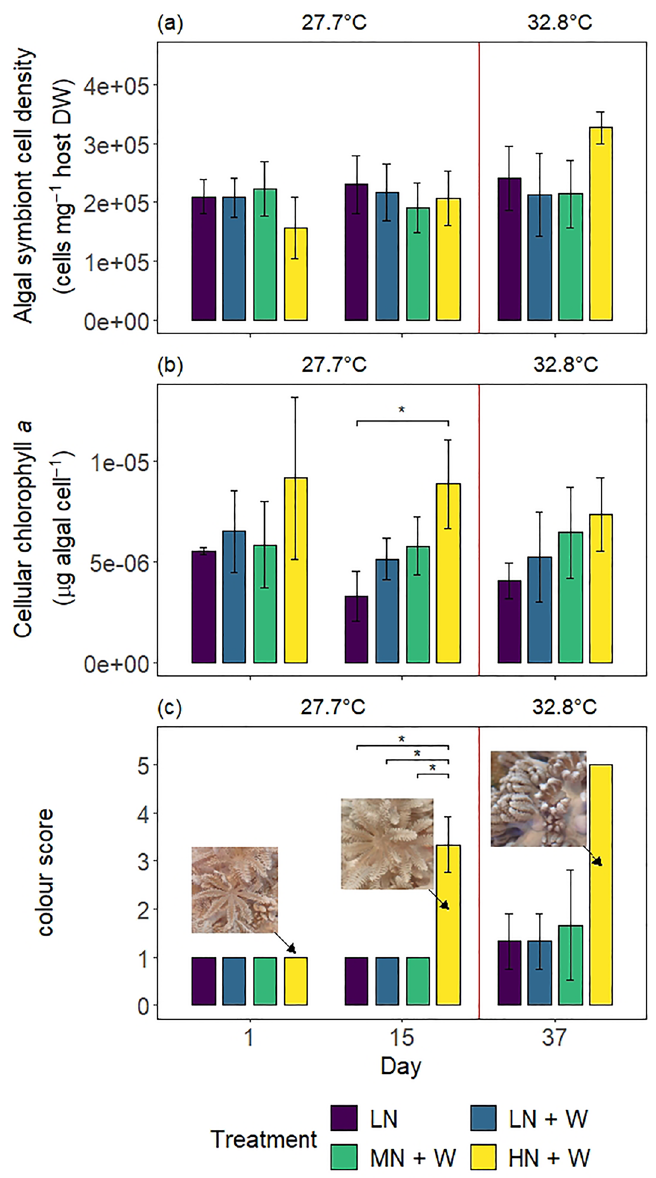
Figure 4. ( a ) Algal symbiont cell density, ( b ) chlorophyll a content standardized to cell density, and ( c ) colour scores (definitions in Supplementary Table S2, see also Supplementary Fig. S3) of Xenia umbellata colonies from control tanks with low nitrate (LN, ~ 0.6 μM) and three treatments: LN + W = low nitrate (~ 0.6 μM) + warming from day 17; MN + W = medium nitrate eutrophication (~ 6 μM) + warming from day 17; HN + W = high nitrate eutrophication (~ 37 μM) + warming from day 17. Error bars represent standard deviations of three replicates, with one exception of two replicates for the LN + W treatment on day one for both, ( a ) and ( b ). Temperatures represent mean temperatures of the respective days, excluding controls (LN). Asterisks represent significant differences between treatments within days (pwc, Bonferroni adjustment, t -test ( b ) or Dunn’s test ( c ), * = p < 0.05). Post-hoc test in ( c ) was conducted excluding day 1. Pictures in ( c ) show representative polyps of one identical X. umbellata colony in the high nitrate treatment at the respective time points (as indicated by arrows). Images in ( c ) by Lisa